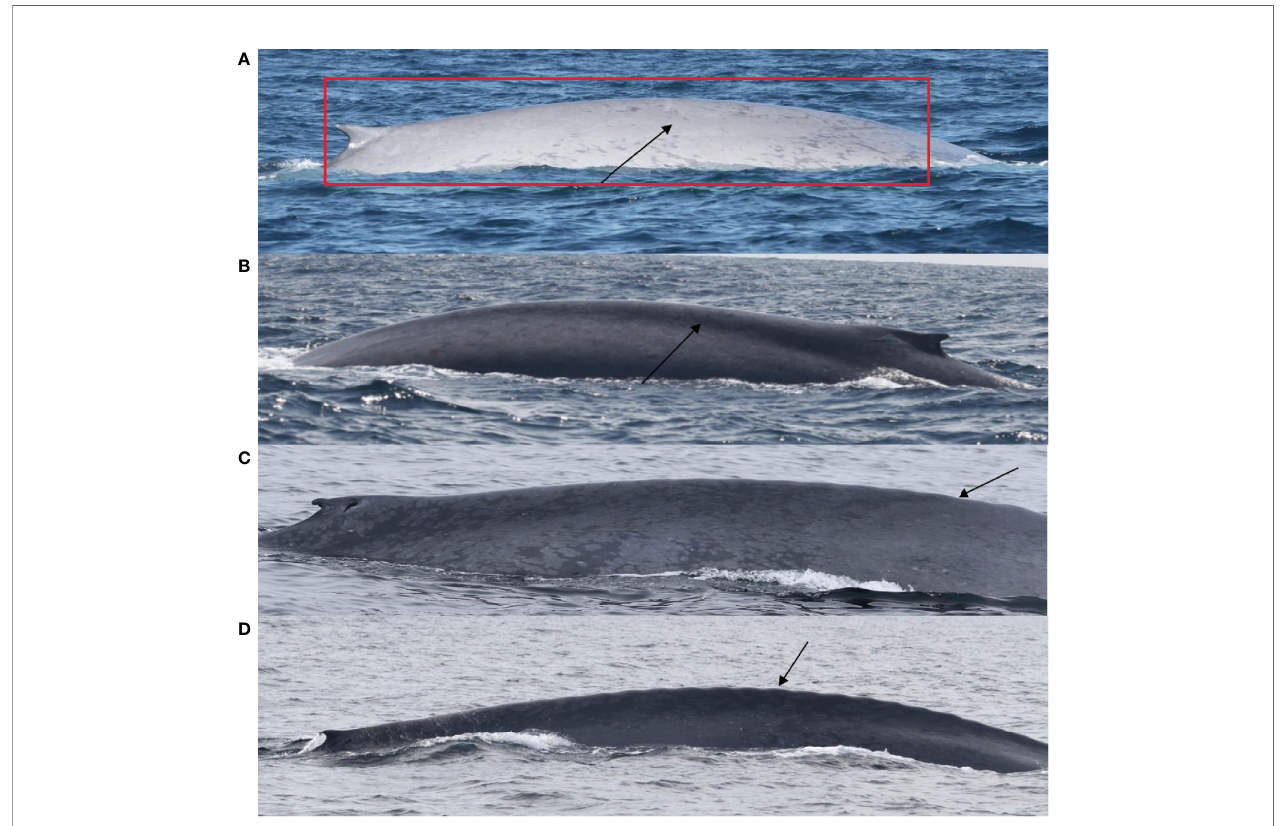
FIGURE 1 | Examples of whales in each category of body condition. (A) Score 0, good body condition, rounded sides and no vertebrae are seen. (B) Score 1, moderately good body condition, a de fi nite dorsal ridge and possible detectable vertebrae. (C) Score 2, a moderately poor body condition, a de fi nite dorsal ridge and slight but multiple detectable vertebrae. D) Score 3, poor body condition, a de fi nite dorsal ridge and obvious multiple vertebrae seen. Arrows indicate rounded sides (A) , dorsal ridge (B) , and detectable vertebrae (C, D) . The red box indicates the area assessed for body condition and proportion of image seen. All images have scores of 1 for both image quality and proportion of image seen. All images were taken by Cascadia Research